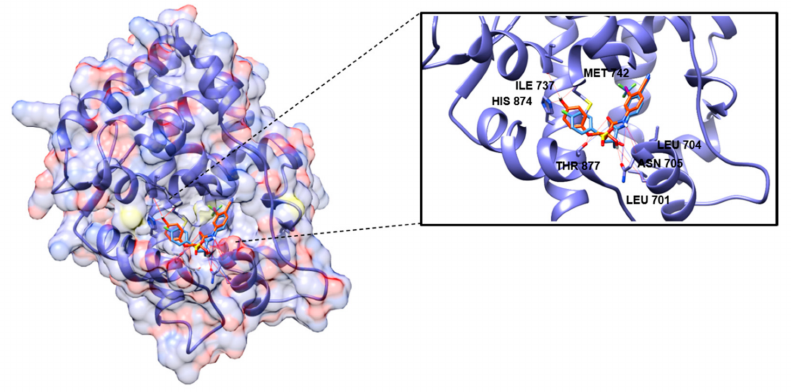
Figure 5. Molecular docking model of 5a (orange) with the projection of bicalutamide (sky blue) in androgen receptor (PDB code: 1Z95), which was visualized using Chimera 1.10 (UC13bSF Chimera).